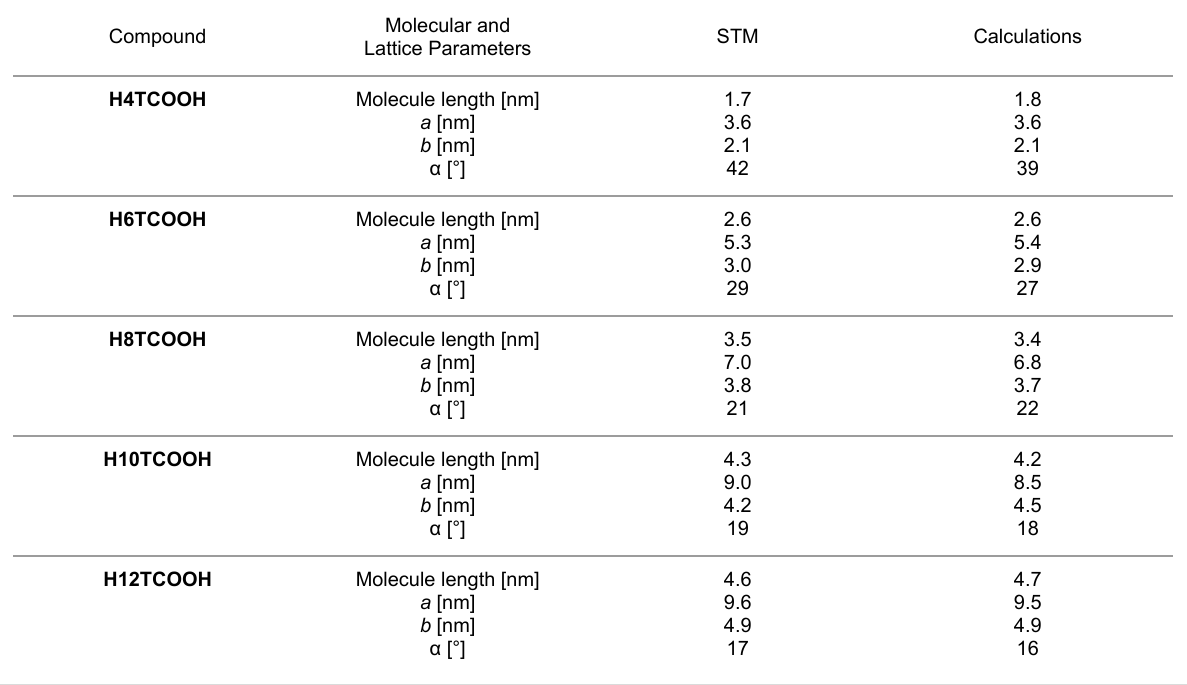
Table 1: STM and theoretical parameters of 2-D crystals of the investigated carboxylic acid functionalized oligothiophenes H n TCOOH .